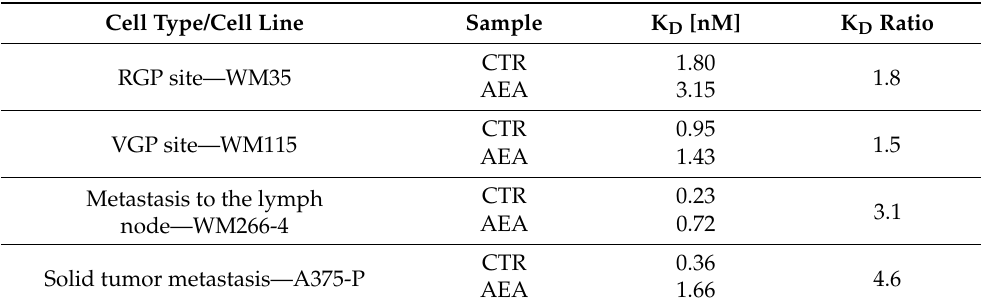
Figure 5. QCM-D results of the lectin–glycan binding measurements performed on AEA-treated and closely related (from the same patient) VGP cells ( A ) WM115 in red) and cells from the metastasis to the lymph node ( B ) WM266-4 in blue). The corresponding relations of the reverse in relaxation time plotted as a function of lectin Con A concentration with the established linear regressions were used to deliver the kinetic parameters of the lectin-glycan interaction (k on and k off ). Table 1. Results of the QCM-D kinetic analysis of the studied lectin–glycan interaction performed on melanoma cells. K D is the dissociation constant/lectin affinity towards cell surface glycans. The K D ratio was calculated as the AEA/DMSO relation.